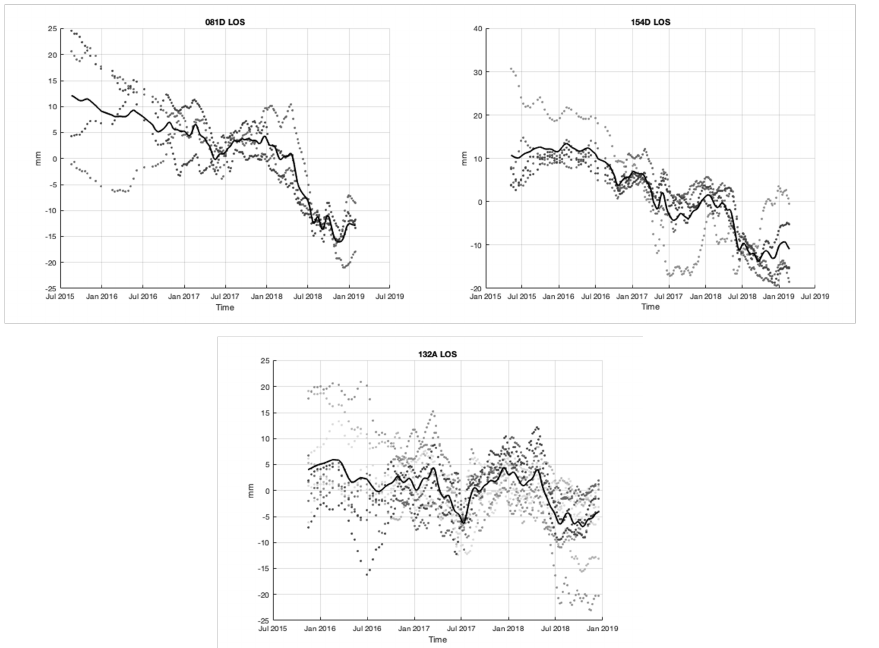
Figure 4. Line of sight (LOS) displacement time series of the pixels shown in Figure 2 measured in the following frames: 081D descending ( top left ), 154D descending ( top right ) and 132A ascending ( bottom ) frame. The dots show individual time series and the line is their average.